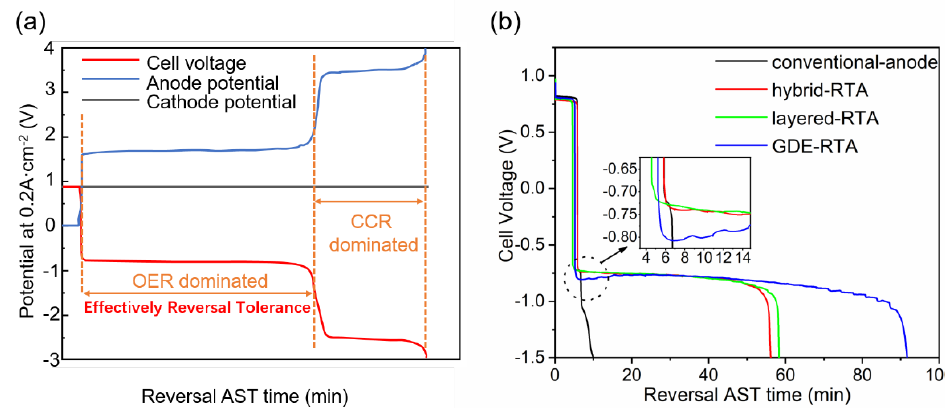
Figure 2. Schematic diagram of cell reversal tolerance ( a ) and cell voltage–RTT curves ( b ) of prepared MEAs with different RTA structures.